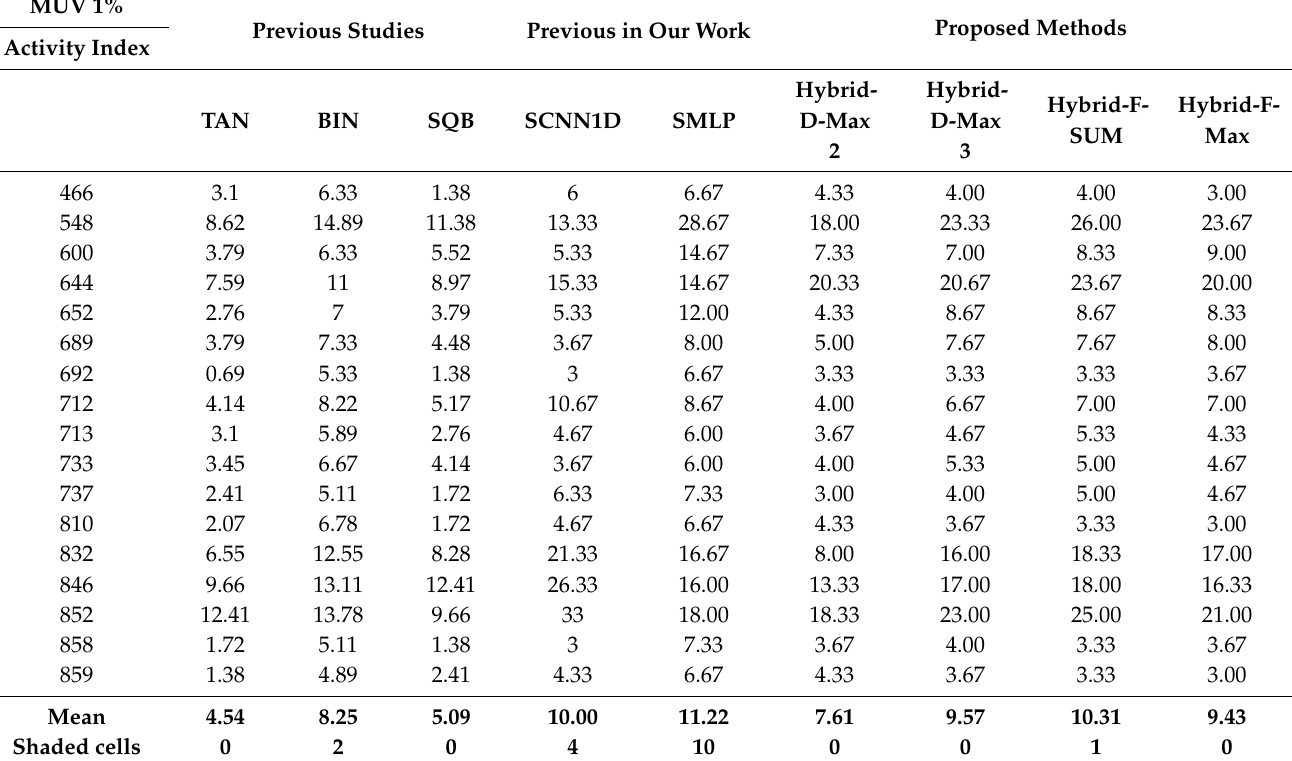
Table 11. Top 1% retrieval recall for MUV dataset for descriptor